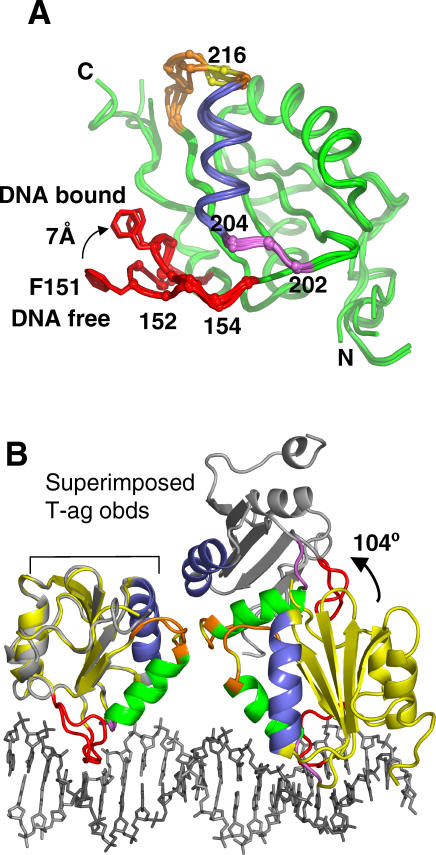
Superposition of T-ag obd Monomers(A) The five nonequivalent crystallographically observed T-ag obd monomers (two from the co-structure, two from the dimer structure, and one from the spiral hexamer structure) are superimposed and displayed in a tube representation. The coloring is as follows: A1 (red), B2 (purple), B3 loop (amino acids 215–220, orange), Cys216 (yellow), and everything else (green). The side chain of Phe151 is shown to indicate the range of motion of A1 loop. The DNA-free (“up”) and DNA-bound (“down”) positions of the A1 loop are indicated.(B) Comparison of T-ag obd co-structure and disulfide-linked dimer structure. A superposition of the T-ag obd dimer onto the T-ag obd co-structure is displayed as a ribbon diagram. Loops A1, B2, and B3, helix αB, and helix αC are colored as above. The rest of the T-ag obd in the co-structure is colored yellow; the rest of the disulfide-linked dimer is gray. One T-ag obd monomer of the disulfide-linked dimer (gray) was superimposed on one T-ag obd monomer (yellow) from the co-structure. The superimposed monomer is shown on the left. The relative orientation of the second monomers differs by 104°.